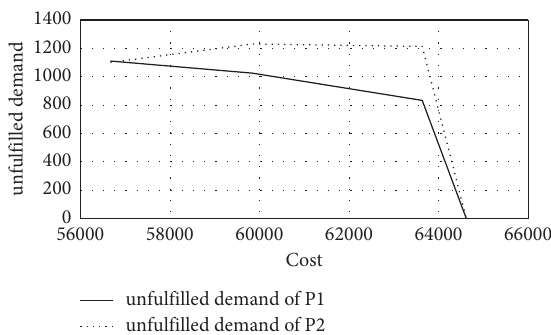
Figure 3: Trade-off between total cost, unfulfilled demand, and ( ω )